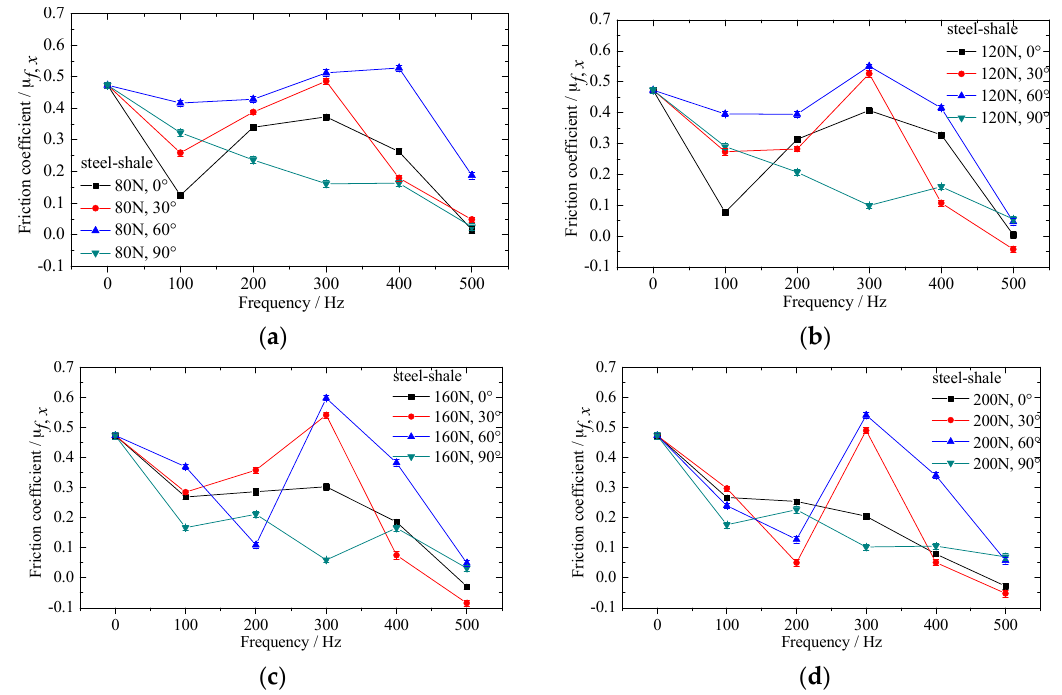
Figure 7. Effect of in-plane vibration on frictional coefficient between alloyed steel and shale.